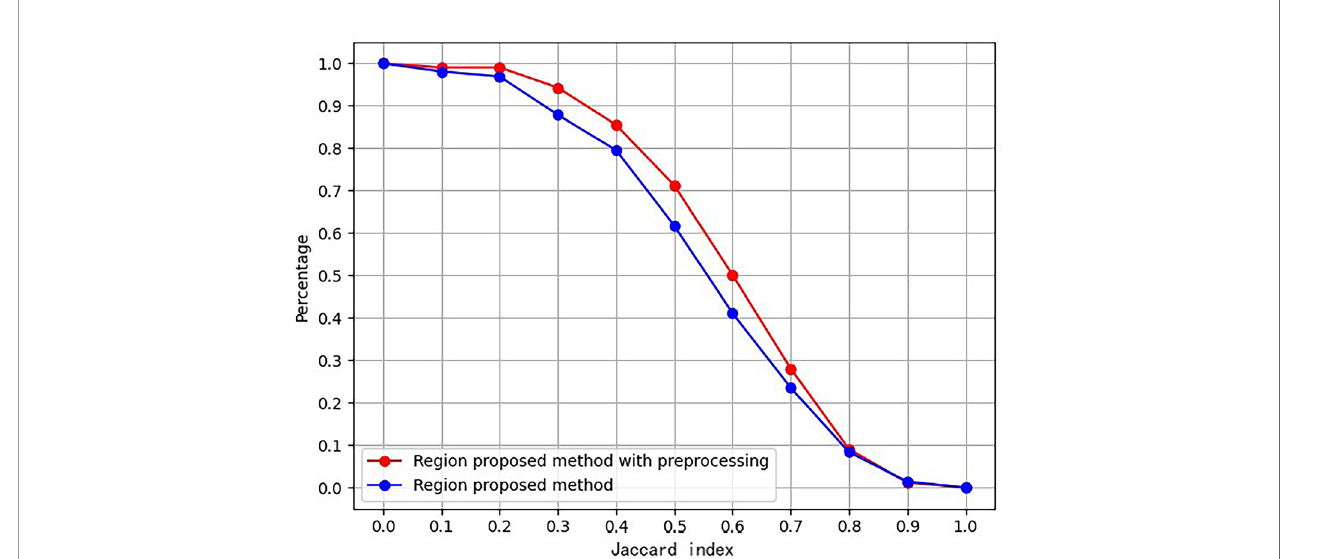
FIGURE 4 | Ablation study to prove effect of proposed preprocessing